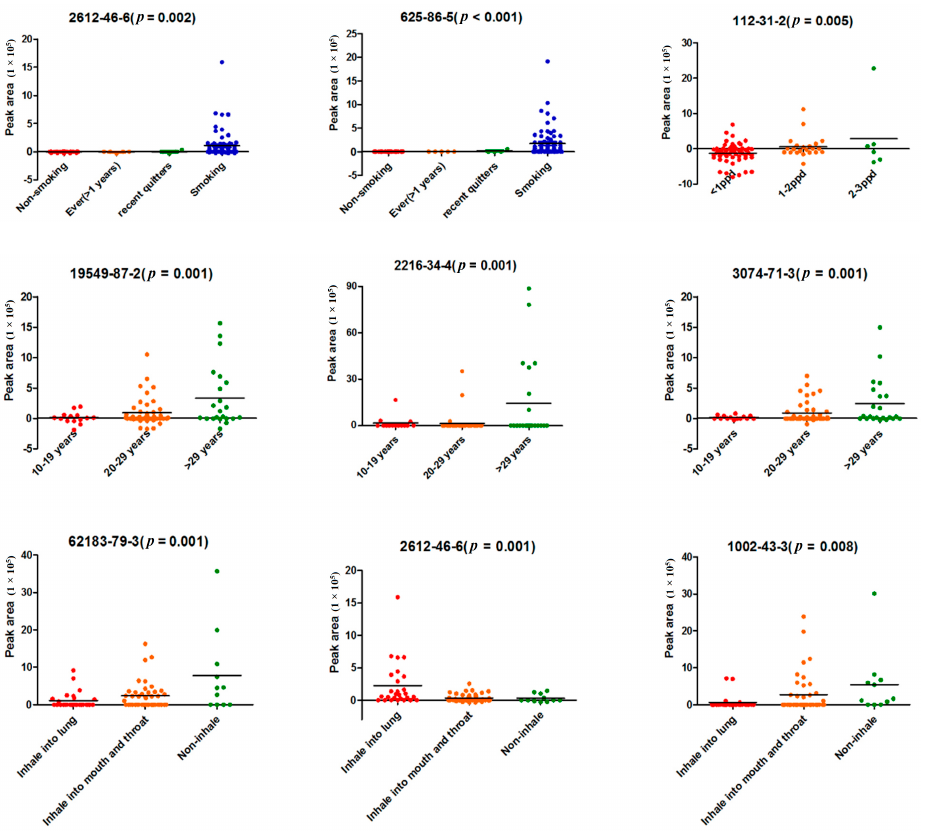
Figure 4. VOCs that were highly significantly correlated with smoking characteristics. (CAS No. 625-86-5, No. 112-31-2, No. 2216-34-4, and No. 62183-79-3 and No. 2612-46-6 remained significant in the